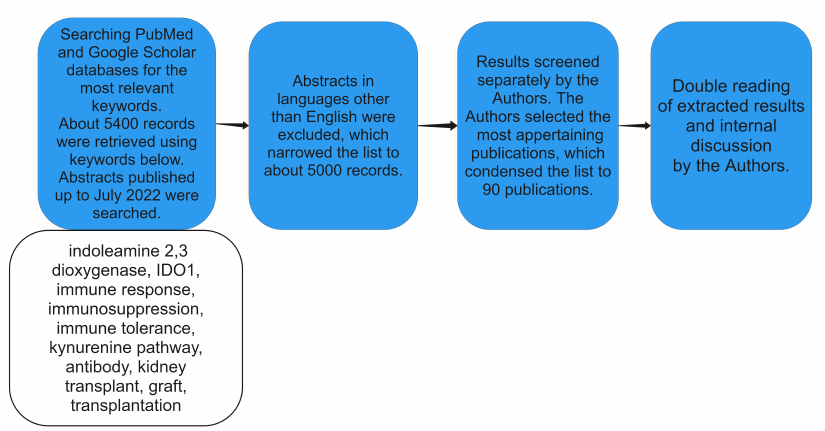
Figure 1. Strategy of data collection presented as a flow